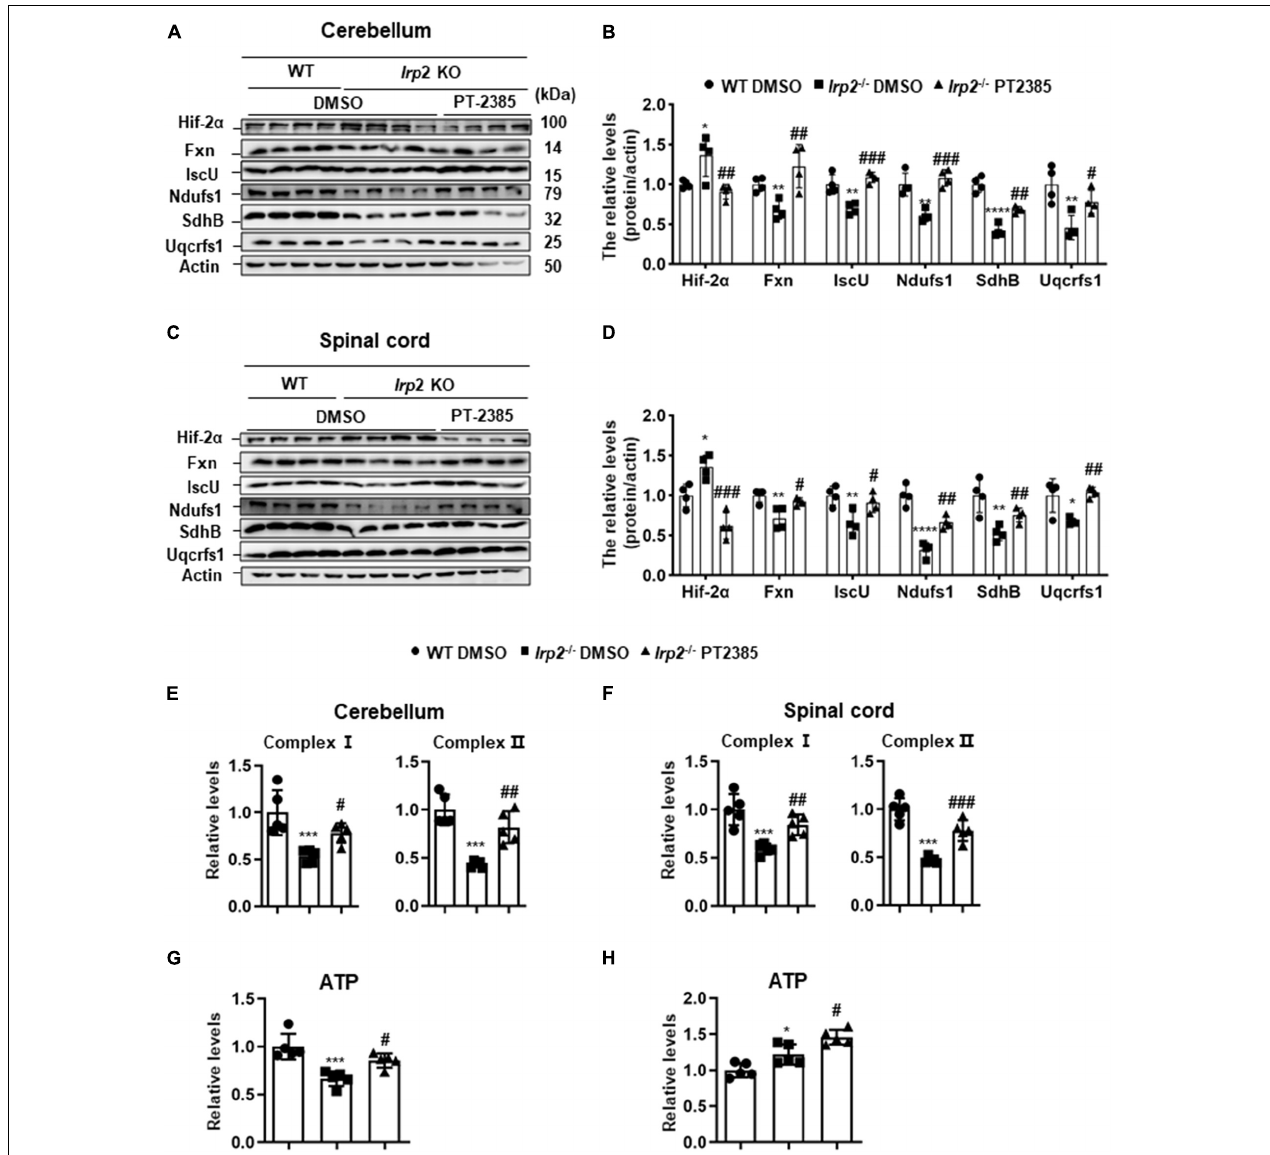
FIGURE 4 | Inhibition of Hif2 α by PT-2385 effectively rescues mitochondrial function in the cerebellum and spinal cord of Irp2 − / − mice. (A) Protein levels of Fe–S biogenesis-related genes (Fxn and IscU) and mitochondrial complex subunits (Ndufs1, SdhB, and Uqcrfs1) in the cerebellum detected by western blot analysis. Actin was used as an internal control. (B) Quantification of the band intensity for panel (A) . (C) The same proteins as in panel (A) in the spinal cord detected by western blot analysis. Actin was used as an internal control. (D) Quantification of the band intensity for panel (C) . (E,F) Activities of electron transport chain (ETC) complexes I and II of the cerebellums (E) and spinal cord (F) . (G,H) The ATP content in the cerebellum (G) and spinal cord (H) . Values represented the mean ± SD n = 3–5, and the ANOVA was used for statistics to evaluate the group differences. In panels (B,D–H) , * P < 0.05, ** P < 0.01, *** P < 0.001, **** P < 0.0001, Irp2 − / − DMSO vs. WT DMSO; # P < 0.05, ## P < 0.01, ### P < 0.001, Irp2 − / − PT-2385 vs. Irp2 − / −